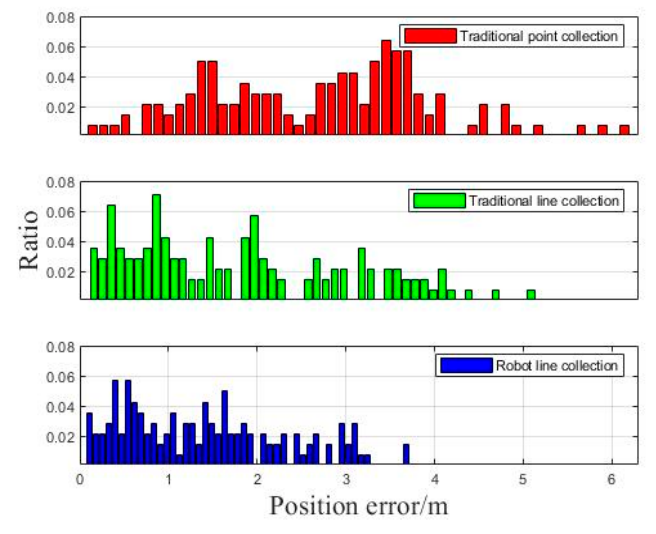
Figure 14. Positioning error of dynamic test.